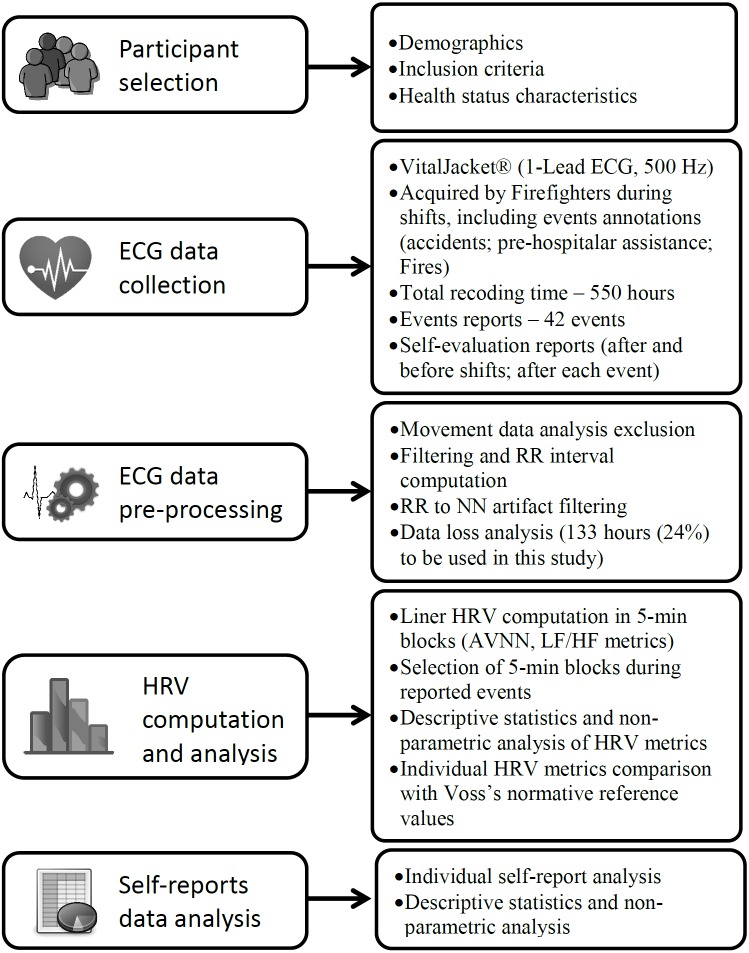
Study method illustration based on Guidelines for Reporting articles in Psychiatry and Heart Rate Variability (Quintana, Alvares & Heathers, 2016).